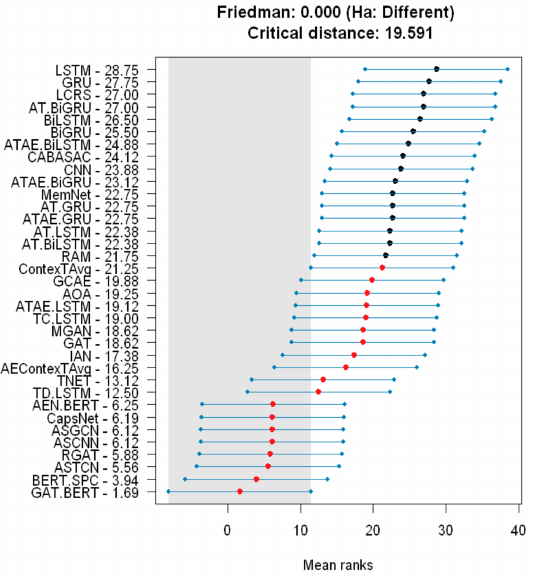
Figure 7. Nemenyi test Critical Distance diagram for 35 deep learning methods for Macro-F1